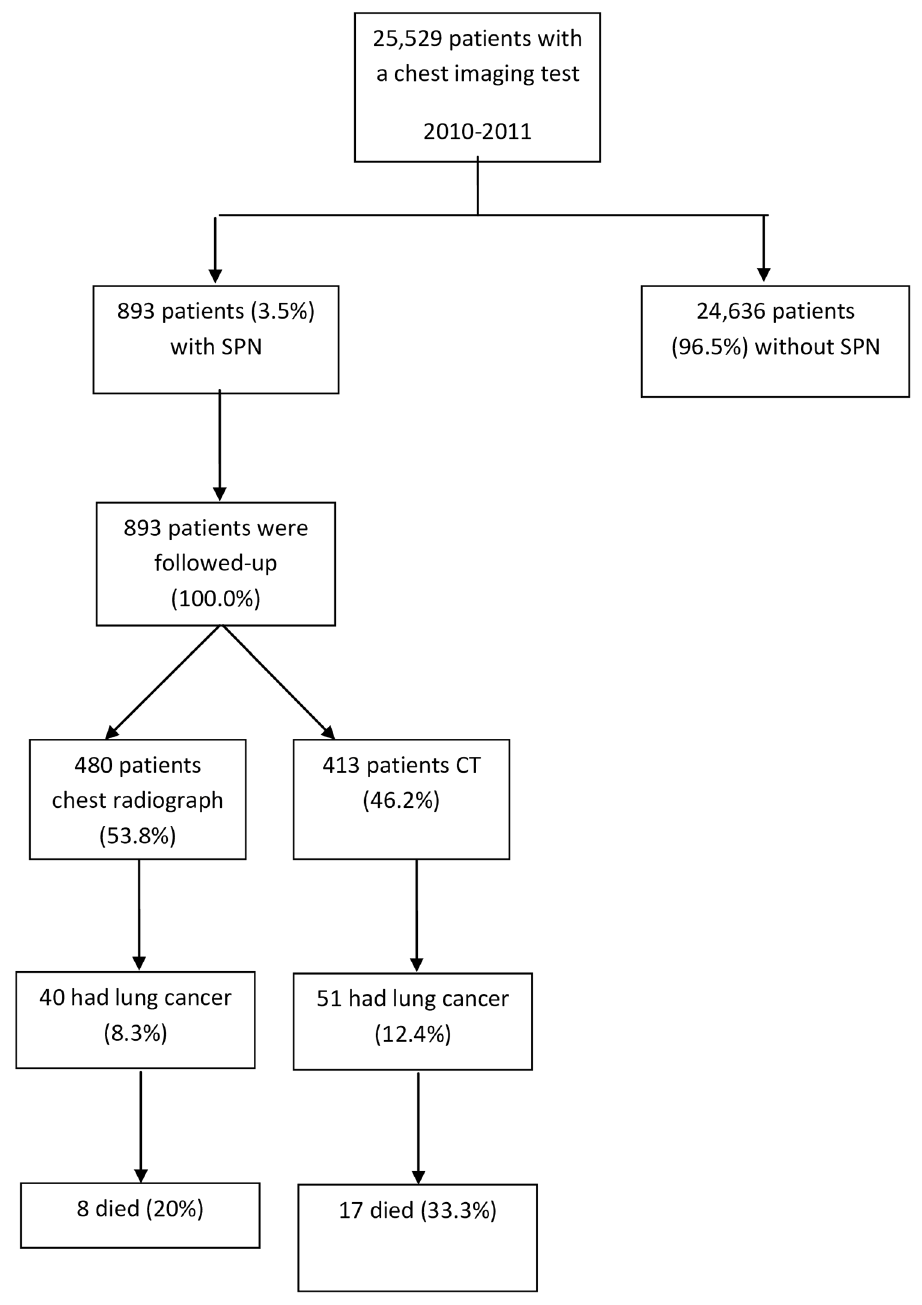
Fig 1. Flow diagram showing the follow-up of the study